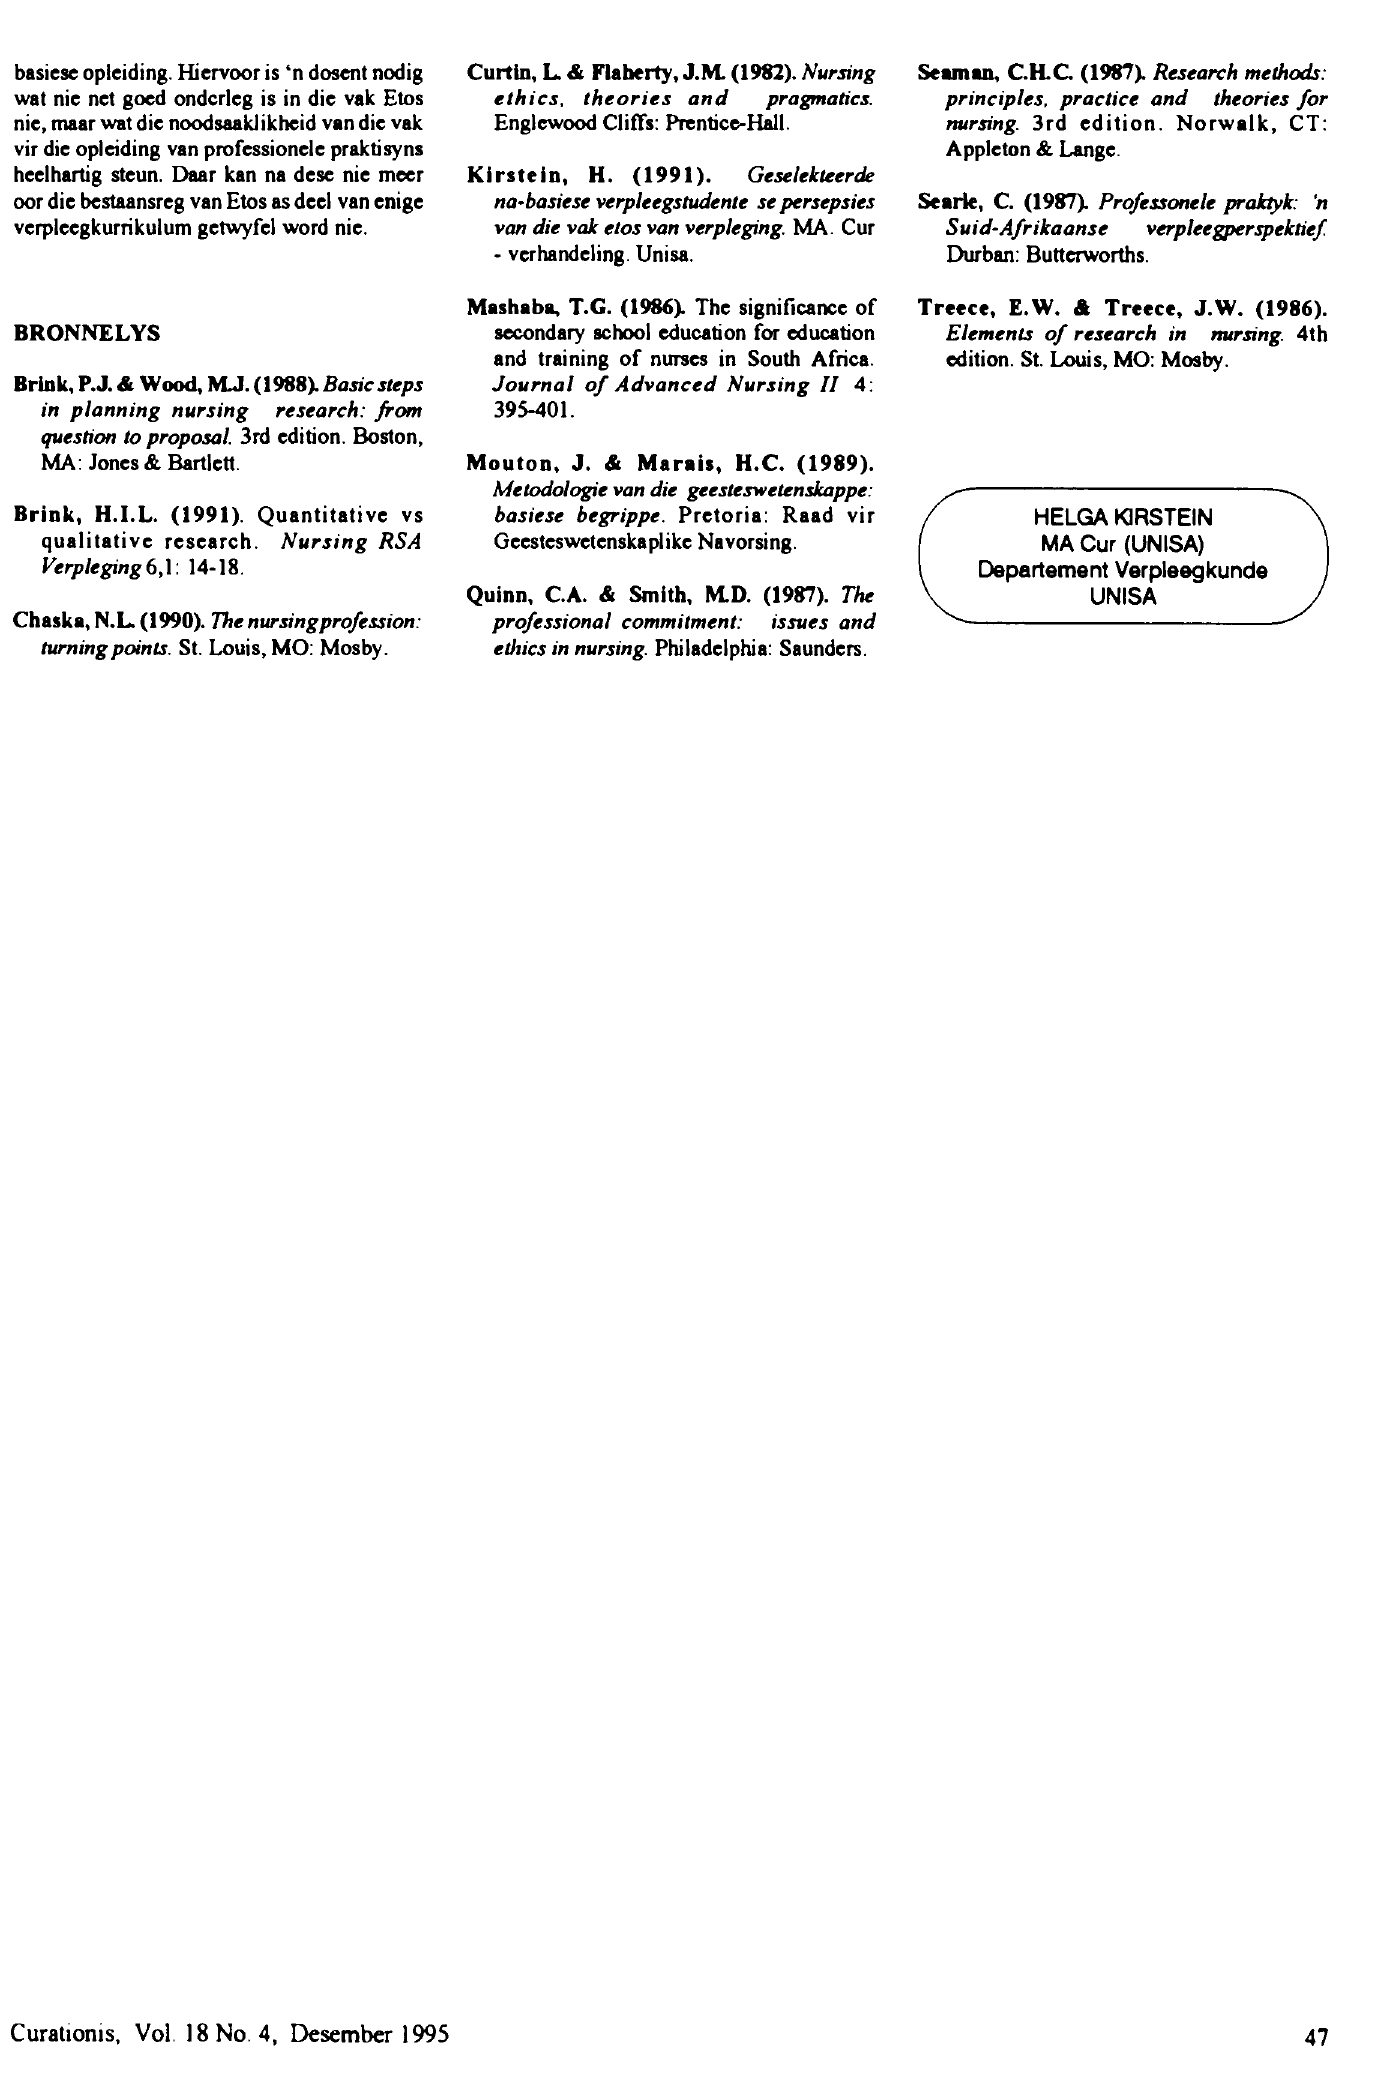
basiese opieiding. Hiervoor is ‘n dosent nodig wat nie net gocd ondcrleg is in die vak Etos nie, maar wat die noodsaaklikheid van die vak vir die opieiding van professionele praktisyns heelhartig steun. Daar kan na dese nie